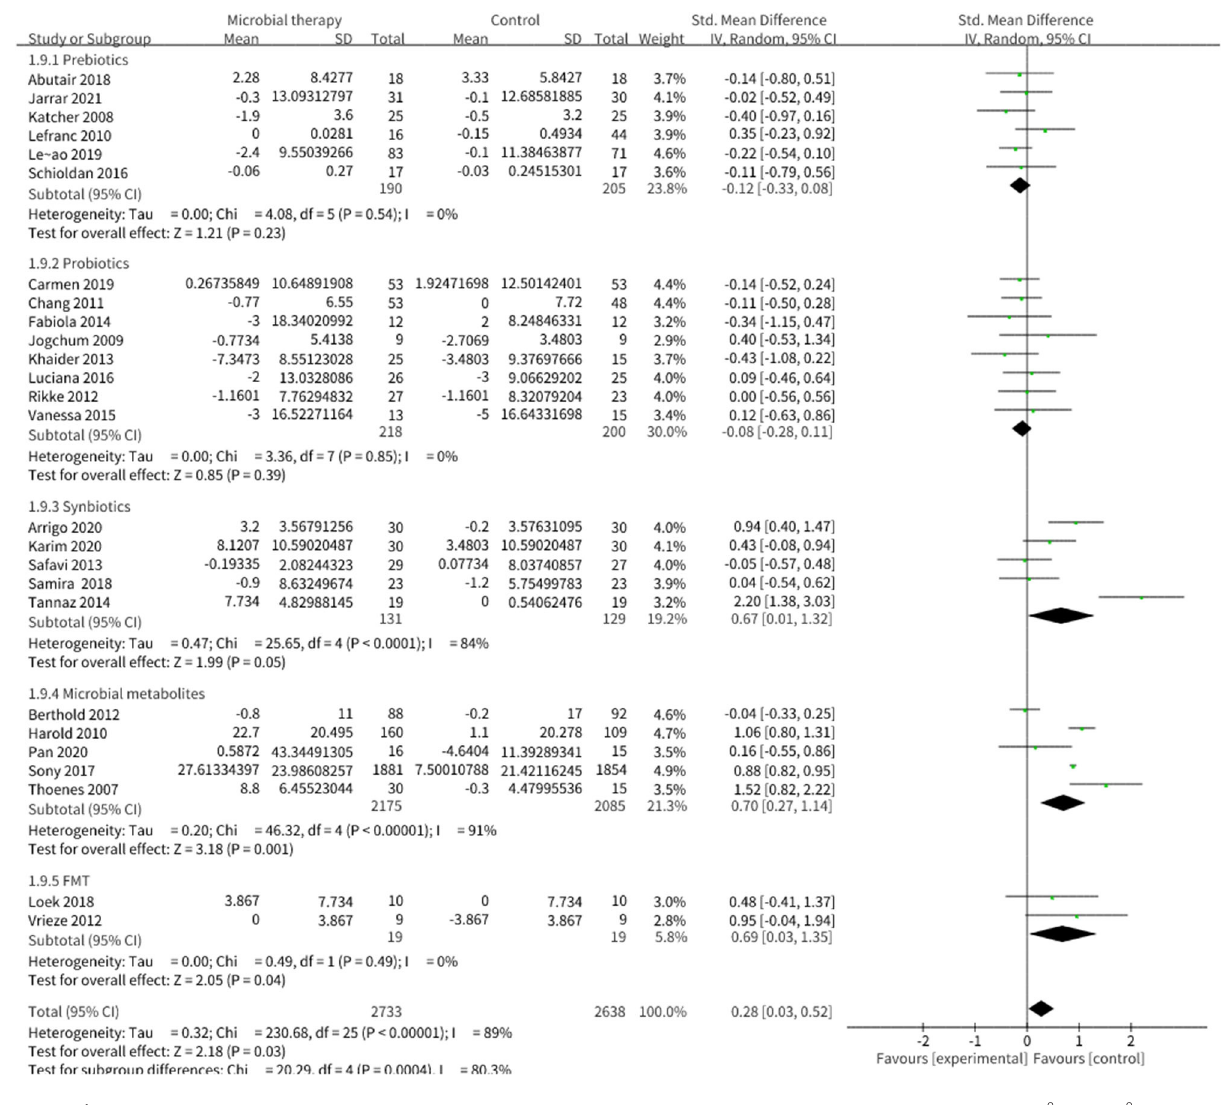
FIGURE 6 | Comparison of SMD of high-density lipoprotein cholesterol (HDL-C) control between intervention groups and control groups Tau 2 = 0.32, I 2 = 89%, 95% CI 0.03 to 0.52, Z = 2.18, p = 0.03. Significant differences were shown in